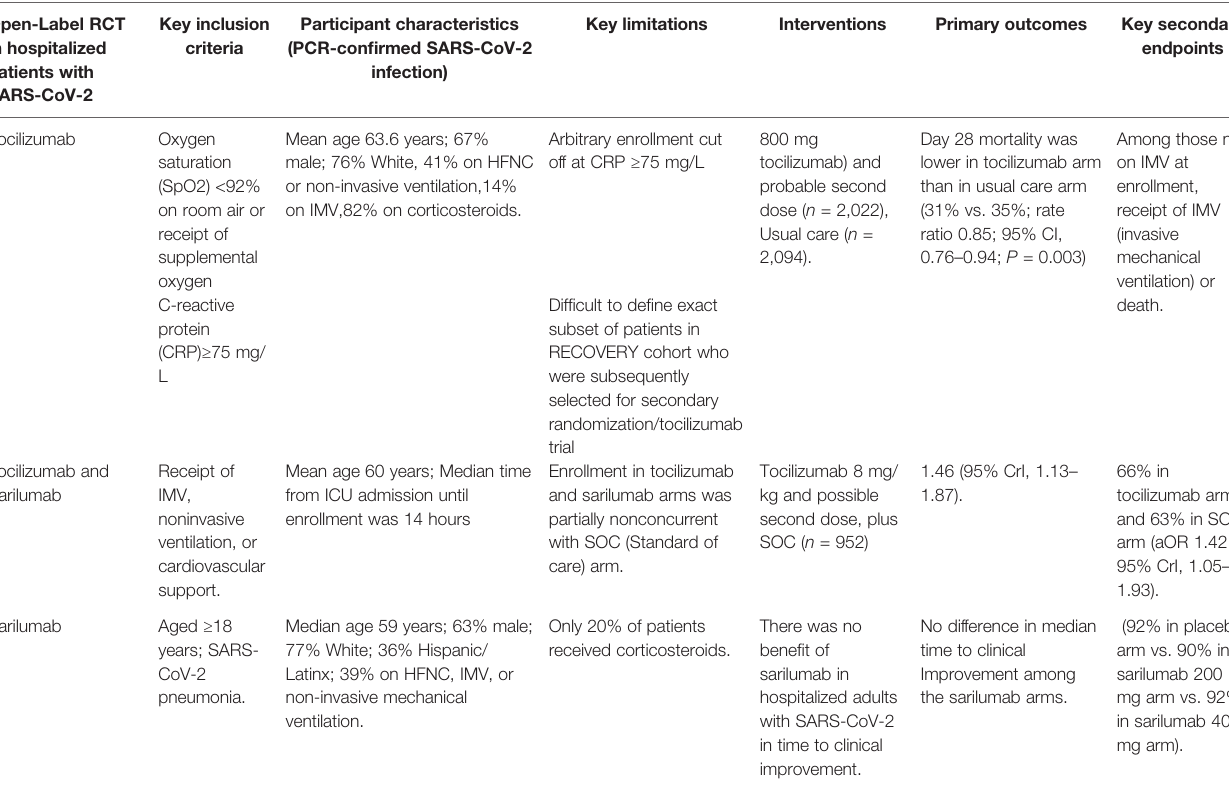
TABLE 5 | Recent updates on clinical evaluation of selected interleukin-6